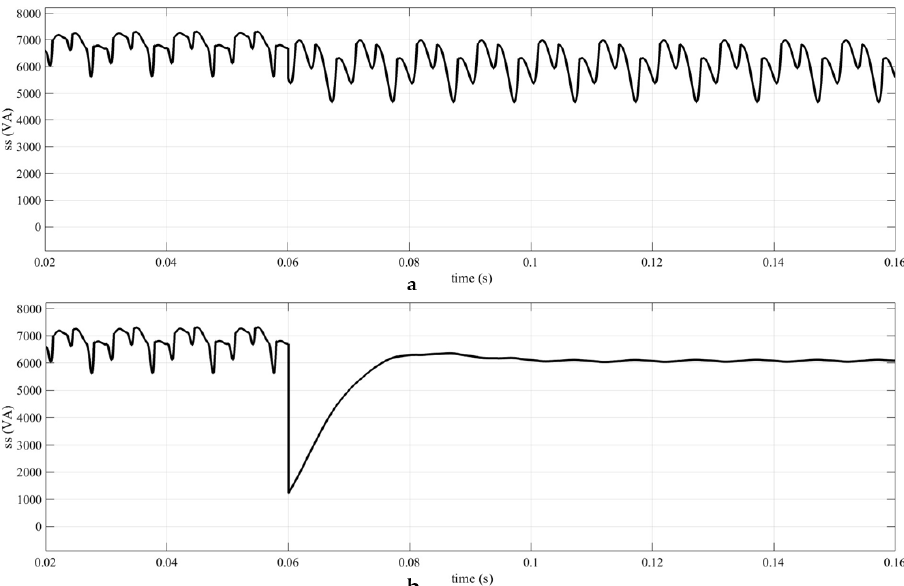
Figure 11. ( a ) Norm of instantaneous power multivector, s s , before/after instantaneous compensation (TIC); s s only includes the instantaneous power after compensation. ( b ) Norm of instantaneous power multivector, s s , before/after average compensation (TAC); s s only includes the average power after compensation once the settling time has elapsed. Compensation at t = 0.06 s.